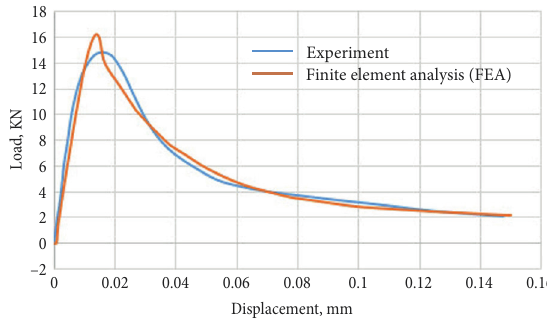
Fig. 16. Comparison of load-displacement responses obtained from FEA and experiment (Zi et al. 2007) in three-point bending notched beam with small size Table 2. Selected parameters which minimize the objective